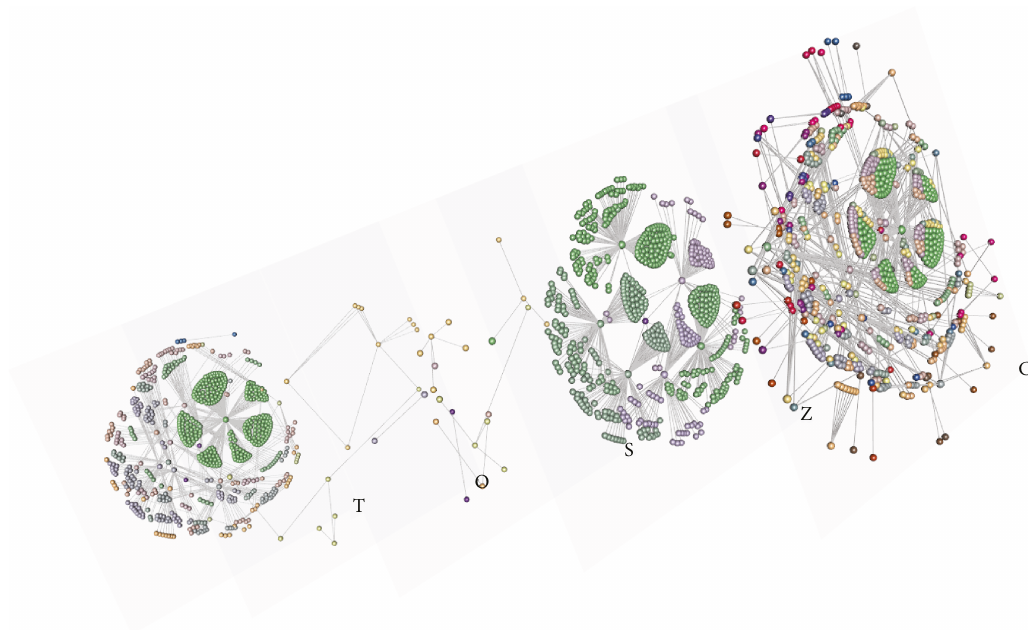
Figure 7: Multilayer network representing the details of the work of the operators (built-in components, C; zones of the activities, Z; skills, S; assignment of the operators to the workstations, O; and activity types, T) (see Table 1 for the detailed de fi nition of the layers).